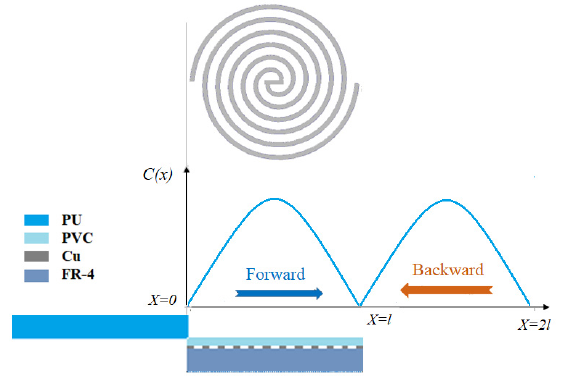
Figure 14. Calculated effective capacitance of the spiral electrode TENG with 4, 8, and 16